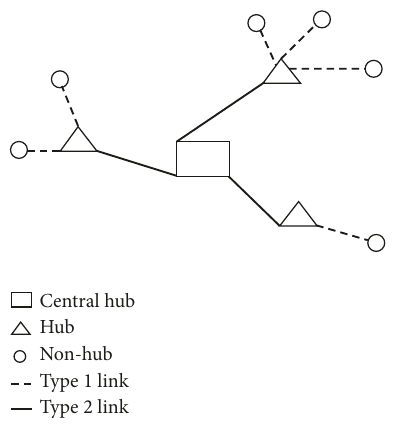
Figure 1: Airline star-star